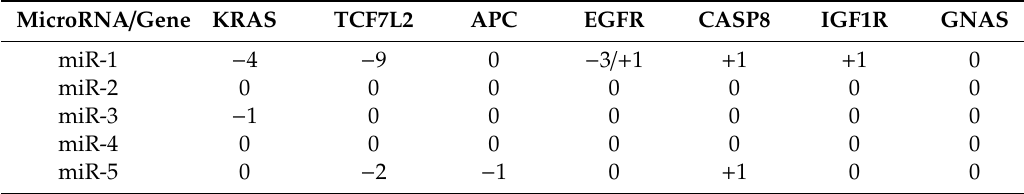
Table 3. Output of the results of trident showing di ff erent binding sites.